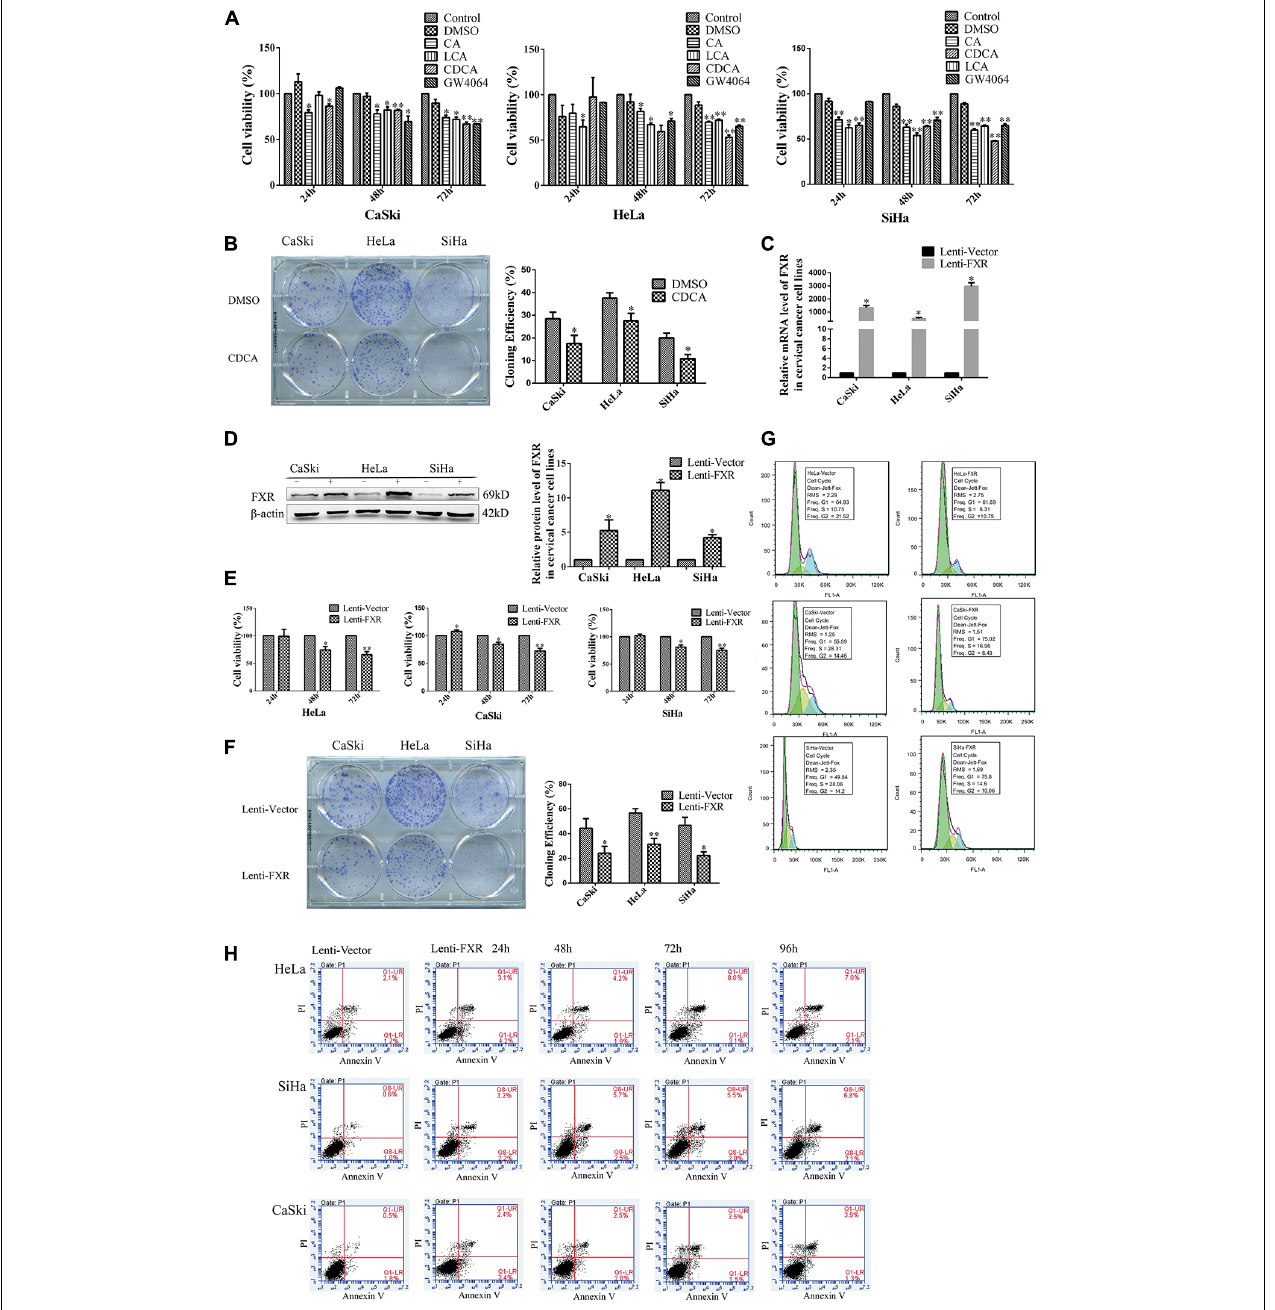
FIGURE 2 | FXR inhibits cervical cancer cell proliferation, inducing G1 arrest and apoptosis. MTT assay of CaSki, HeLa, and SiHa cells following treatment with CA (100 µ g/ml), LCA (40 µ mol/l), CDCA (50 µ mol/l), and GW4064 (2 µ mol/l) (A) . Colony formation of CaSki, HeLa, and SiHa cells treated with CDCA (50 µ mol/l) (B) . ∗ P < 0.05; ∗∗ P < 0.01 vs. DMSO group. CaSki, HeLa, and SiHa cells stably overexpressing FXR were confirmed by qRT-PCR (C) and western blot (D) . Lenti-FXR groups showed reduced proliferation in MTT (E) and colony formation (F) assays, with G1 arrest [fluorescence; (G) ] and apoptosis [flow cytometry; (H) ]. Green, G1; yellow, S; blue, G2. ∗ P < 0.05; ∗∗ P < 0.01 vs. Lenti-Vector